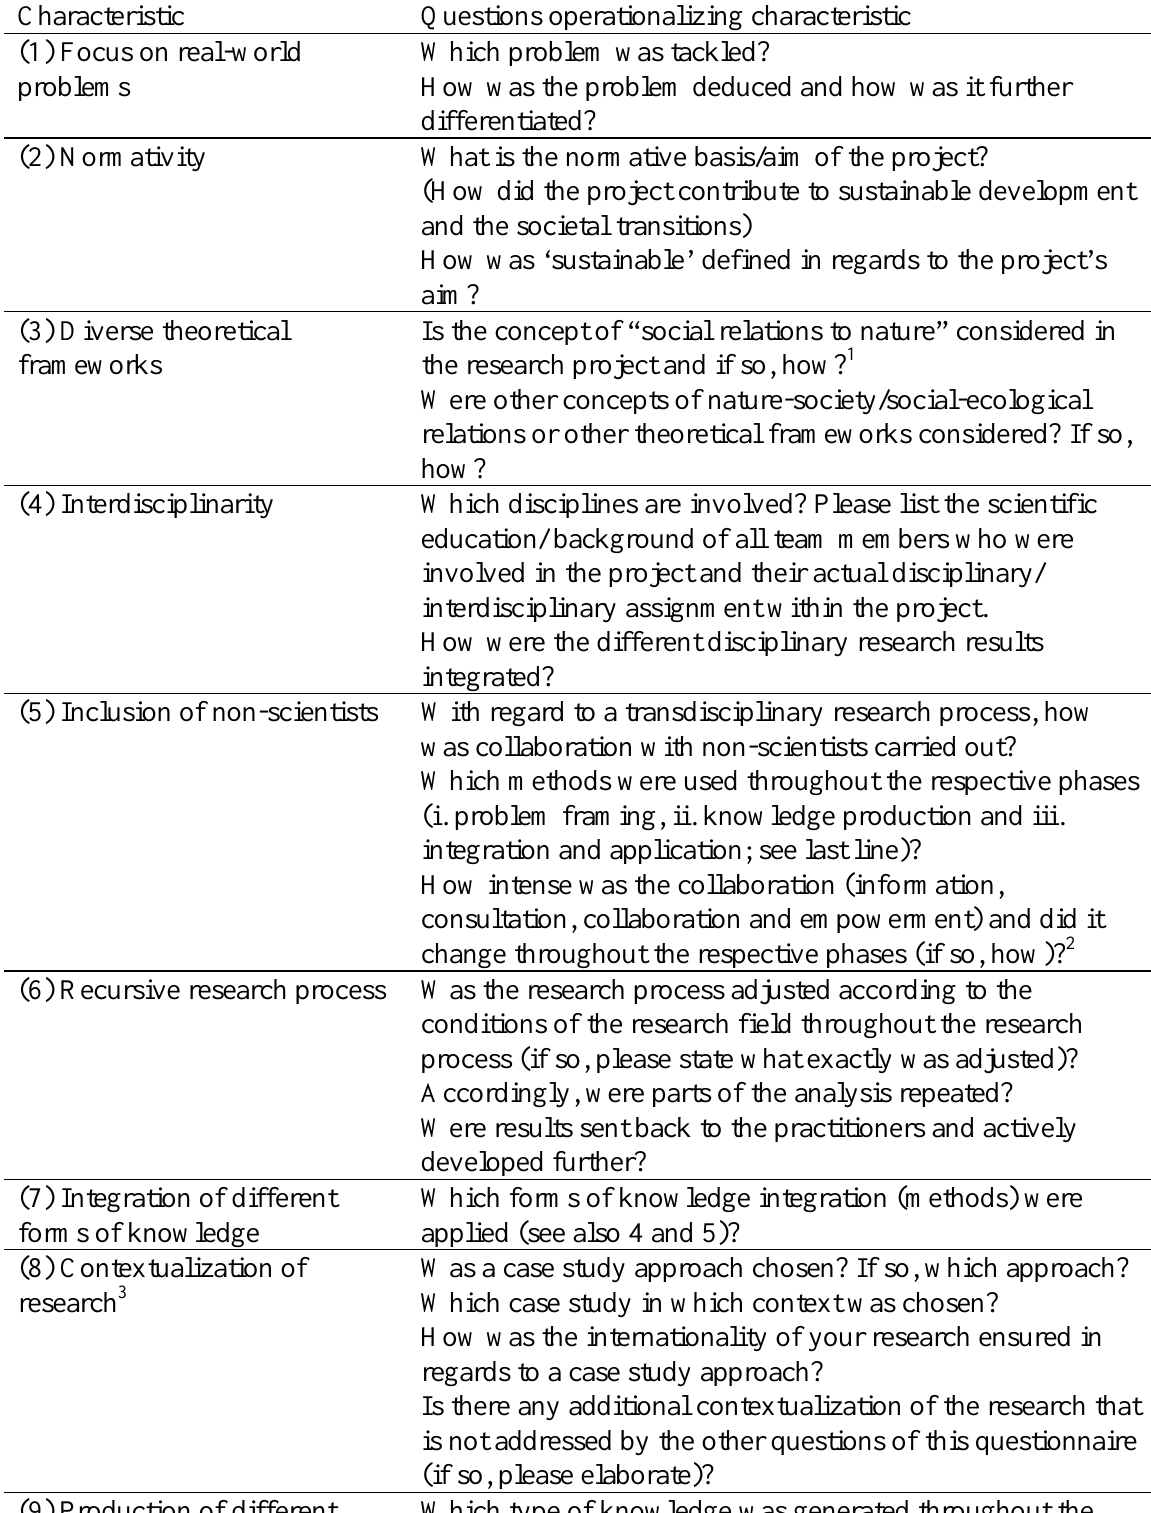
Table A1.1: Operationalization of the derived characteristics of TSS for the questionnaire